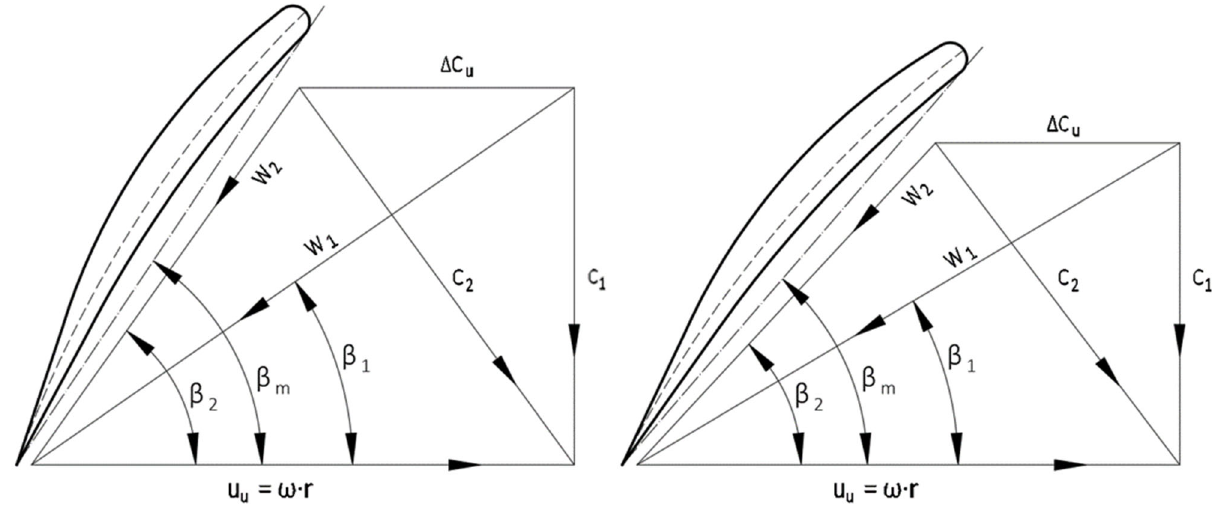
Figure 4. System of velocity vectors for the axial rim cross-section [1] .